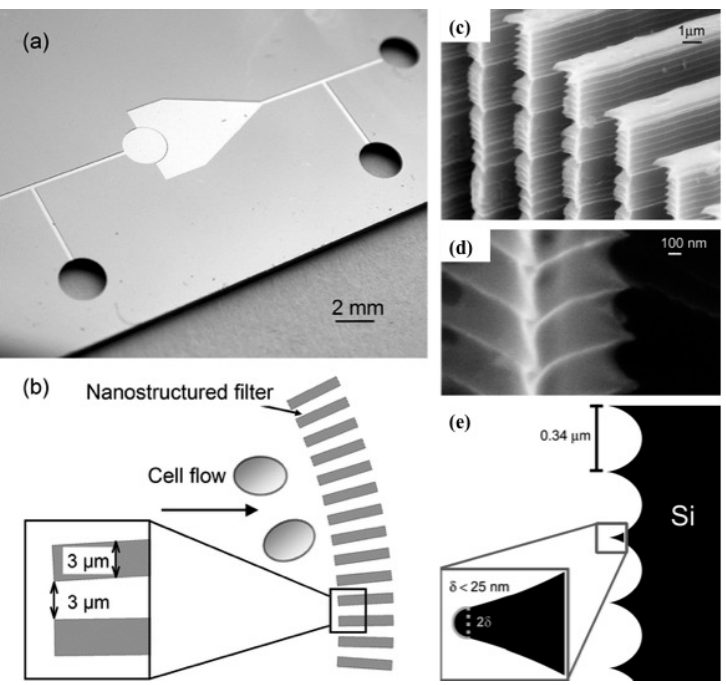
Figure 9. Mechanical lysis using nanoscale barbs: ( a ) microfluidic device showing different inlets and outlet channels; ( b ) schematic of the barbs; ( c ) deep reactive ion etching (DRIE) fabricated nano-knives; ( d ) magnified image of nano-knives patterned using DRIE technique and ( e ) dimensions of the nano-knives used for cell lysis. Reproduced with permission from [52].